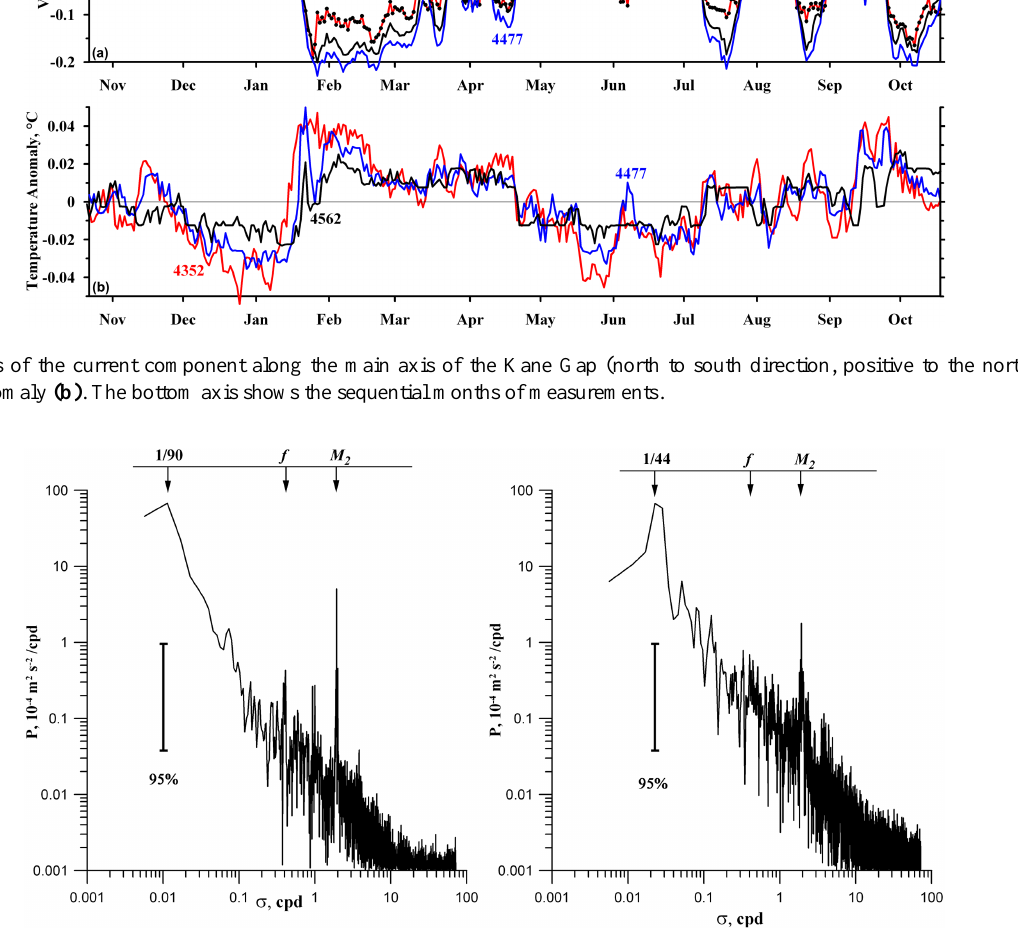
Fig. 12. Nearly raw spectra of kinetic energy from currents at 7m above the bottom for the periods between November 2010 and May 2011 (left) and between May and October 2011 (right). The 95% confidence intervals are